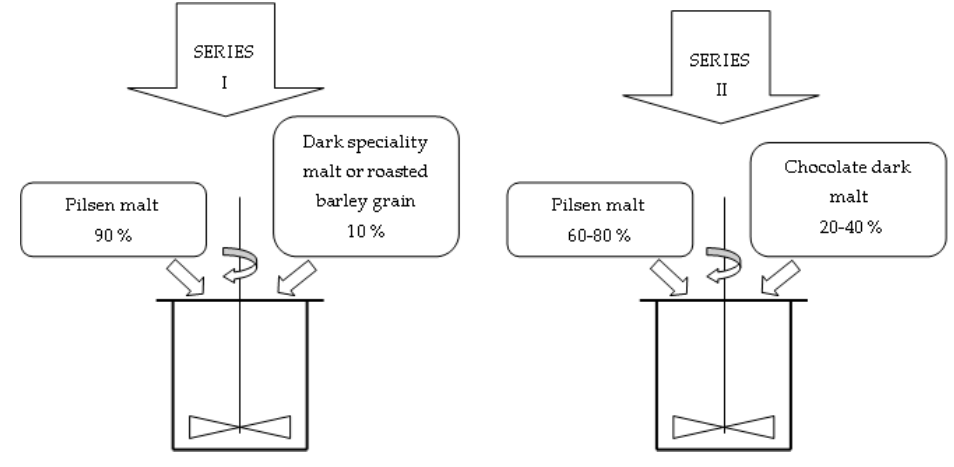
Figure 5. Wort production scheme.